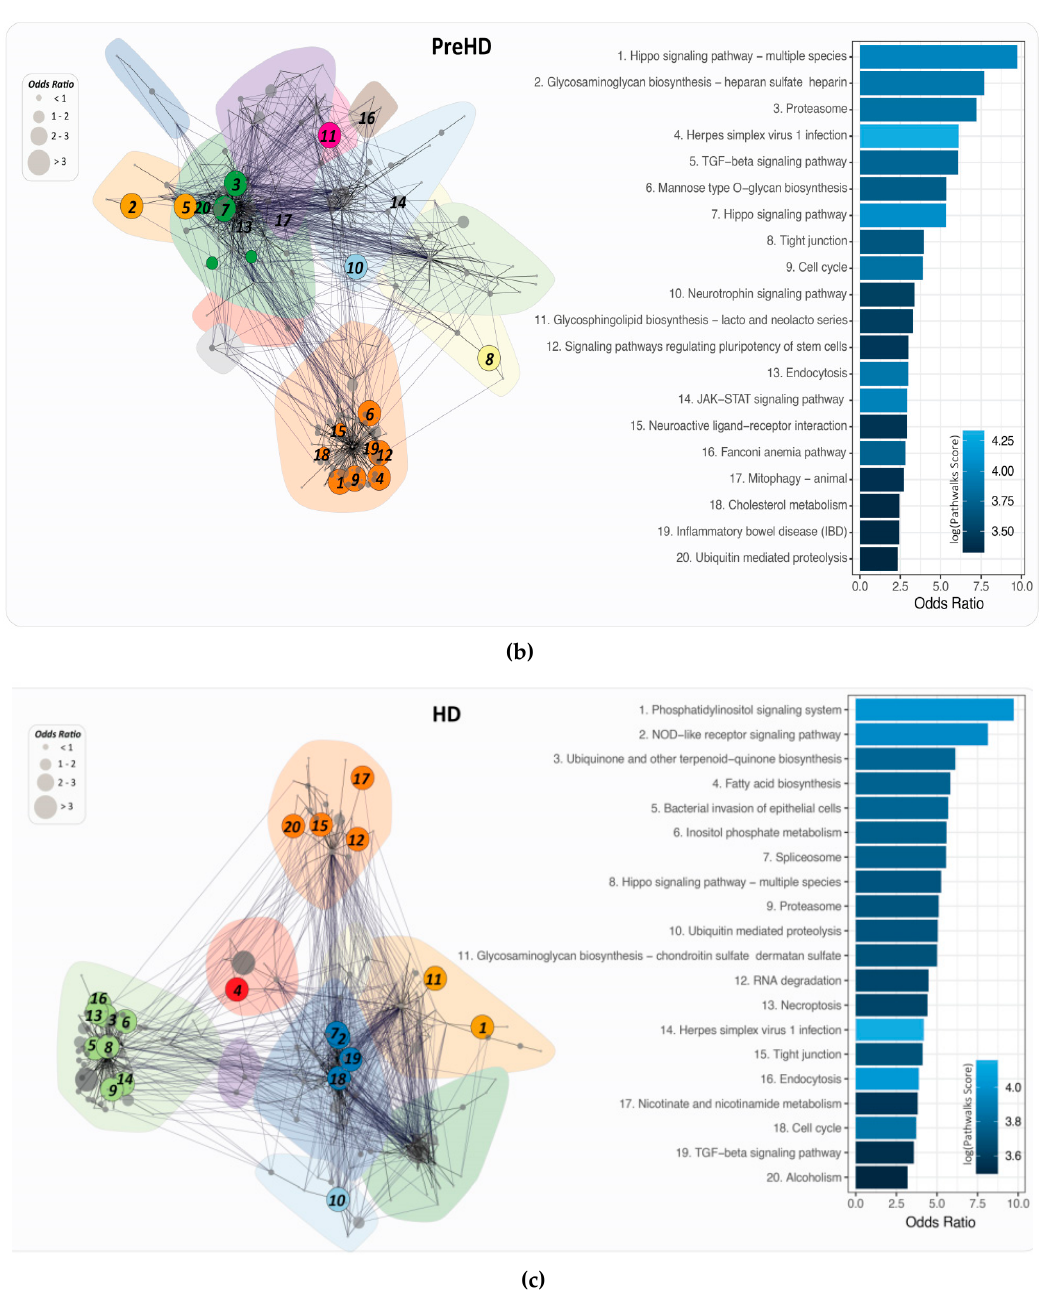
Figure 5. PathWalks derived pathway to pathway networks and odds ratio analysis for ( a ) pre-symptomatic versus symptomatic HD, ( b ) pre-symptomatic HD, ( c ) symptomatic HD. In each network the node size represents the odds ratio (OR) score in 4 bins. The top 20 pathways w.r.t to OR are shown in colour, while the remaining nodes are shown in grey. Edges represent walker transitions between pathways. Colour shading shows the identified communities of highly connected pathways w.r.t to PathWalks scores.